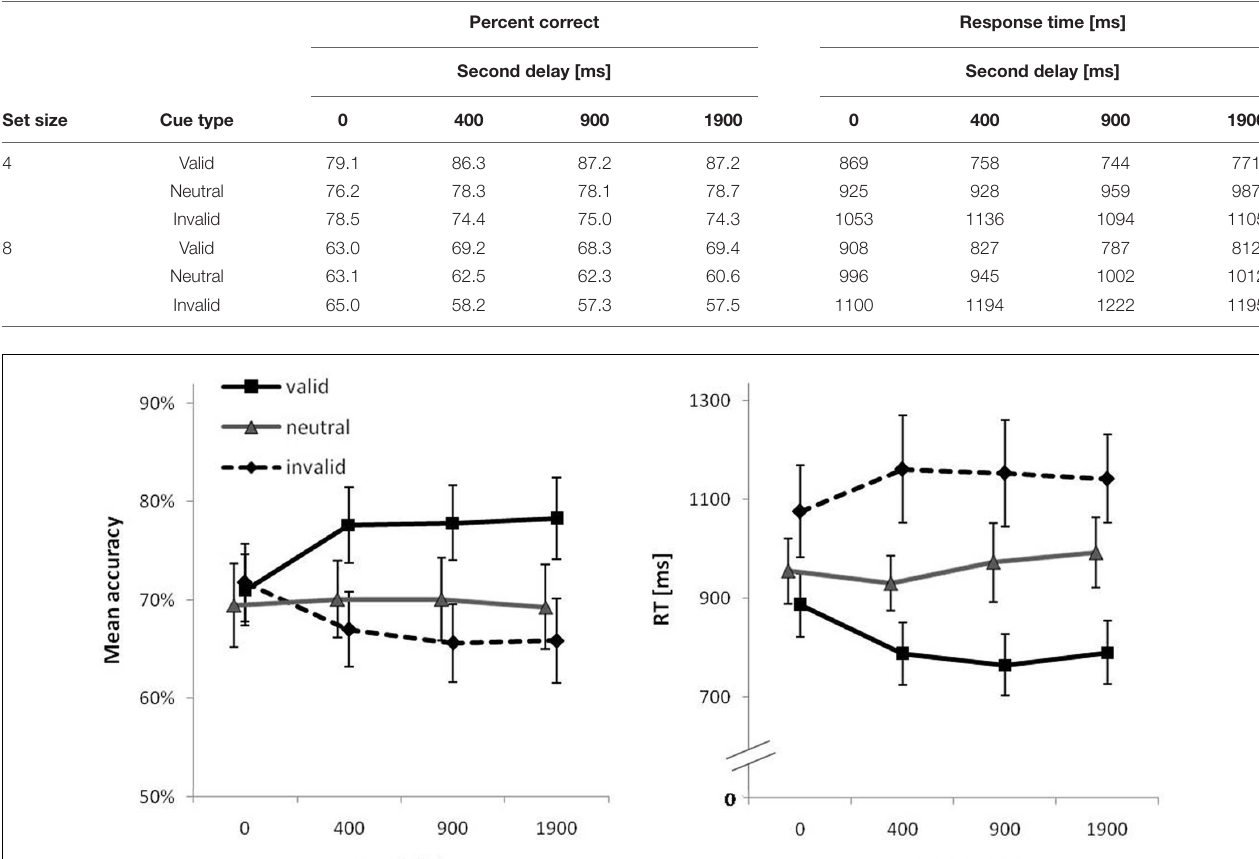
TABLE 2 | Descriptive statistics: mean percent correct and mean correct response times (in ms) as a function of set size, cue type, and second delay duration.